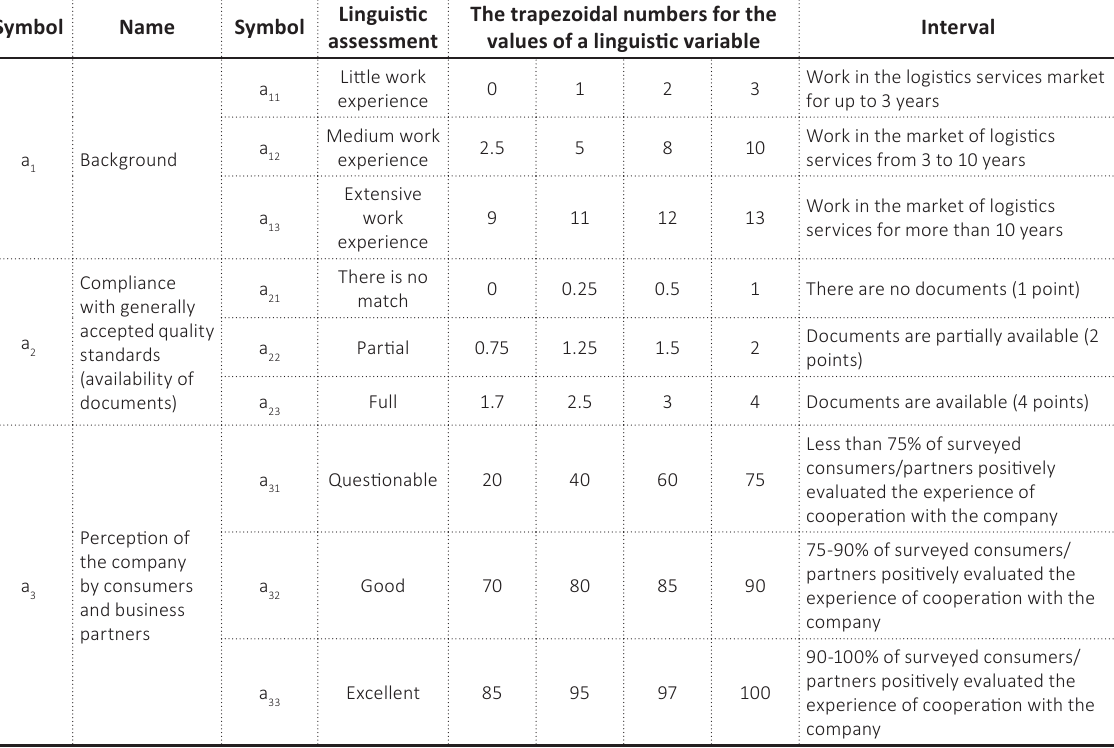
Table A2. Service/product availability/quality assessment indicators (В)